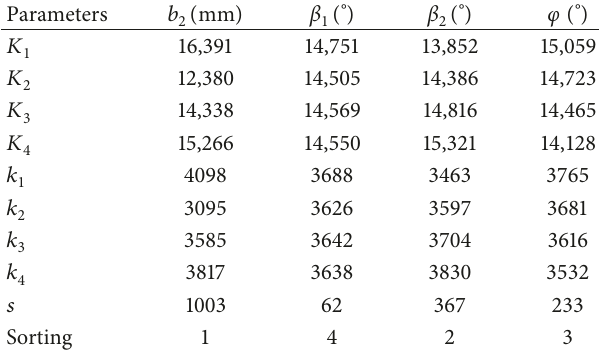
Table 9: Influence analysis of parameters on the NSPH Parameters